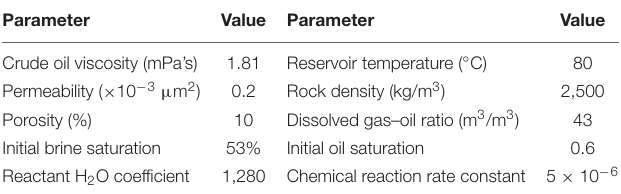
Frontiers in Energy Research |